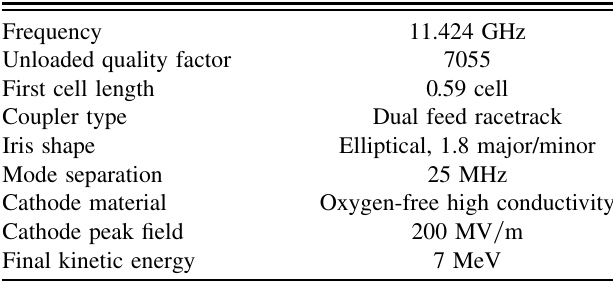
TABLE I. Mark 1 rf gun